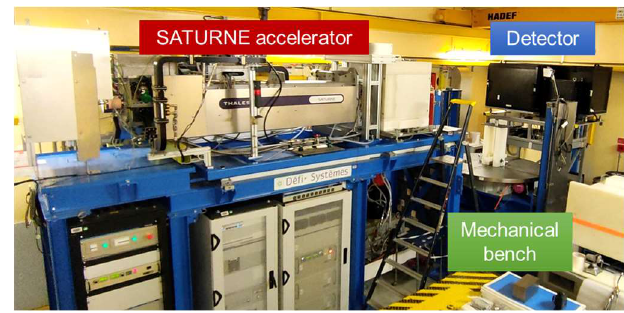
Fig. 1. Panoramic view of the accelerator SATURNE in the CHICADE platform (July